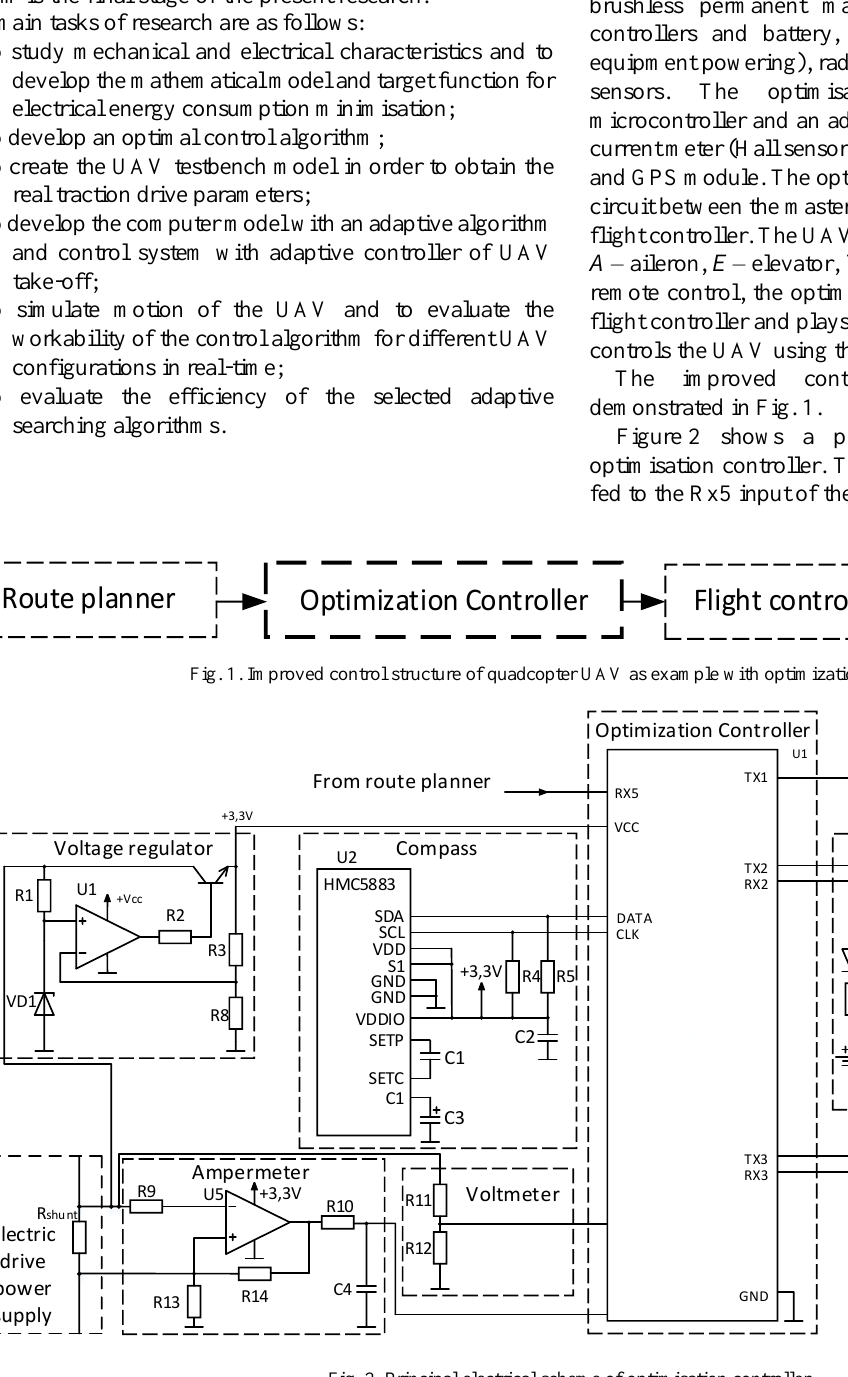
Fig. 2. Principal electrical scheme of optimisation